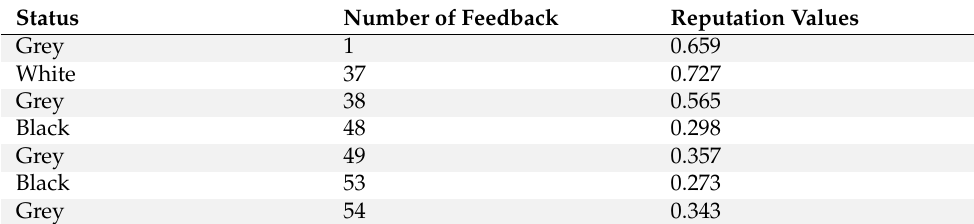
Table 3. Reputation Values representing variation in SP1 status.